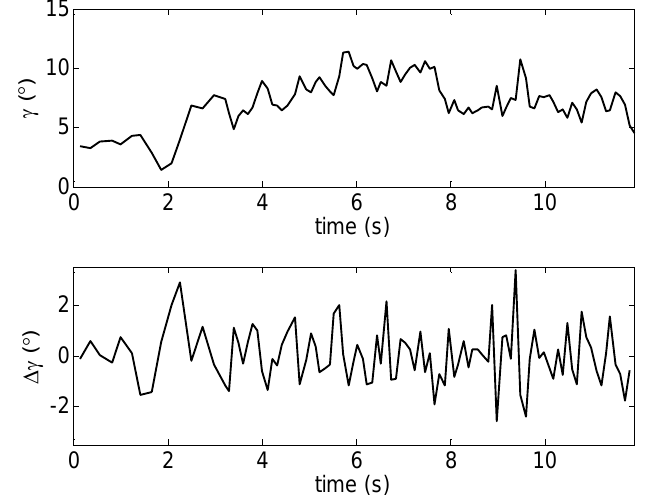
Figure 13. Inclination of the frontal line γ corresponding to the experiment of Figure